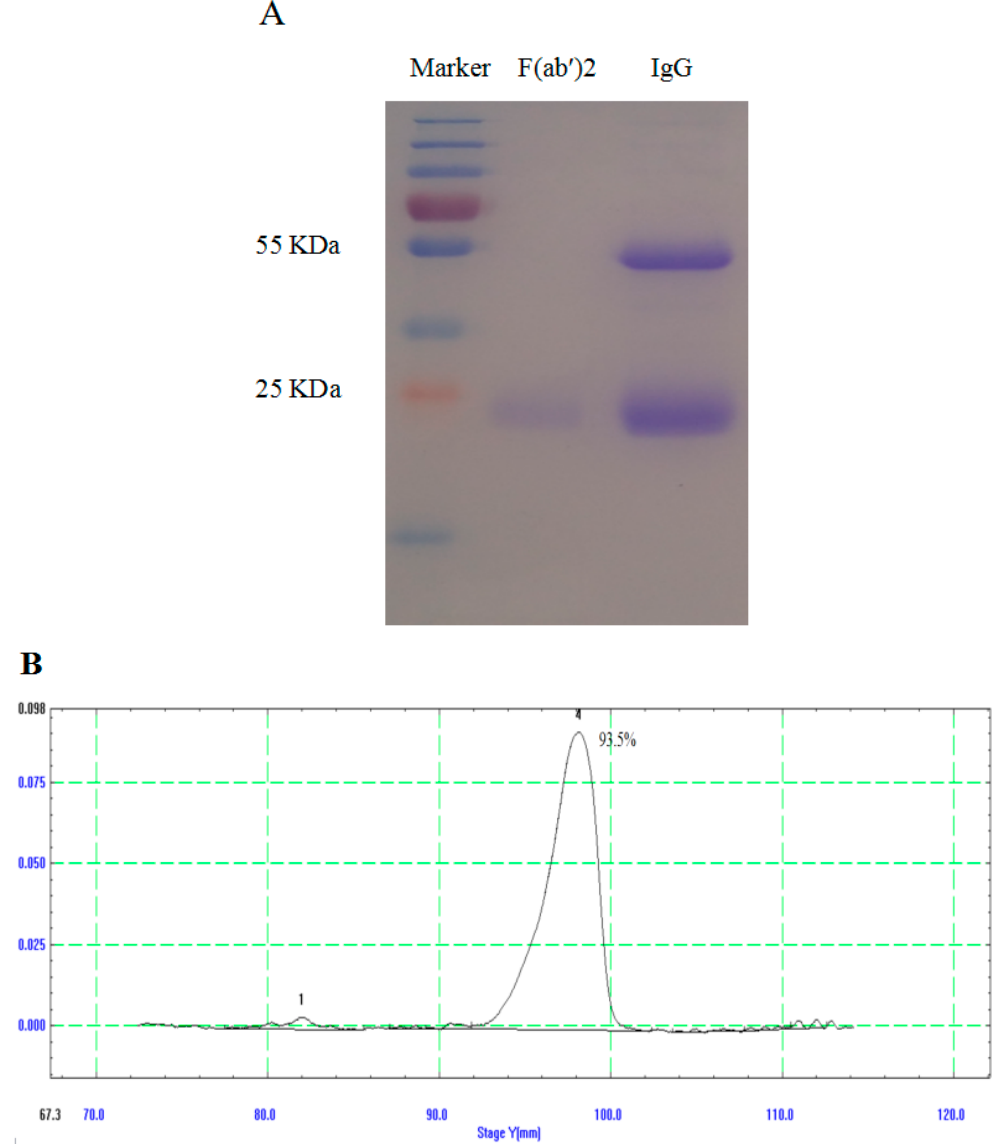
Figure 2. Generation and purification of IgG and F(ab ′ ) 2 . A saturated solution of ammonium sulfate was added to the serum to precipitate the IgG, and F(ab ′ ) 2 was generated by digesting the IgG with pepsin followed by Protein ‐ A/G chromatography. ( A ) SDS ‐ PAGE and Coomassie blue staining of the purified IgG and F(ab ′ ) 2 ; ( B ) The purity of the F(ab ′ ) 2 fragment was determined by a thin slice scan.